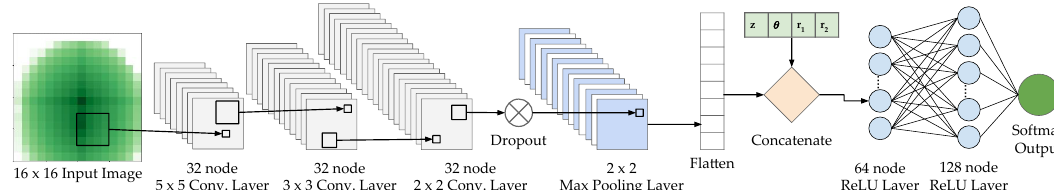
Figure 5. Diagram of 2D CNN for classification of toy model images. When used, XAUG variables are concatenated to the processed outputs immediately before the final two ReLU